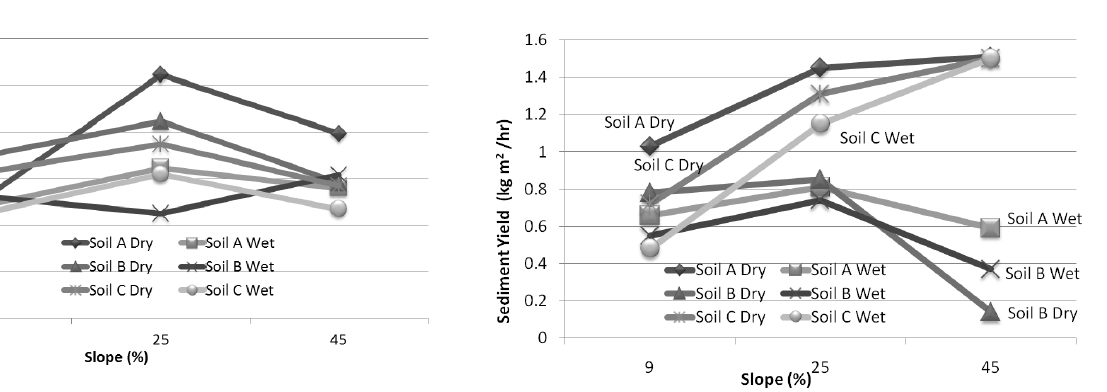
Fig. 3. Effect of the different levels of slope steepness on sediment yield for the three soils at two levels of initial moisture content.